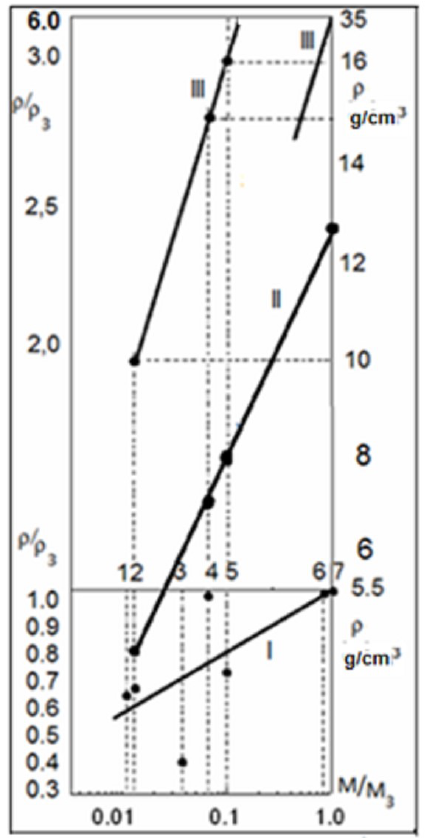
Fig. 8 . Lines: I- the density of planets and satellites (right) and these relative to the Earth’s mass (left). III - the density of gaseous matter at the time of planets and satellites formation. The density of the Earth and Venus is 30-35 g/cm 3 , Mars-16 g/cm 3 , Mercury-15 g/cm 3 , the Moon-10 g/cm 3 . II – the density of cores matter after the expansion stage: 1 - Europa, 2- Moon, 3 - Ganymede, 4 – Mercury, 5- Mars, 6 -Venus, 7 –